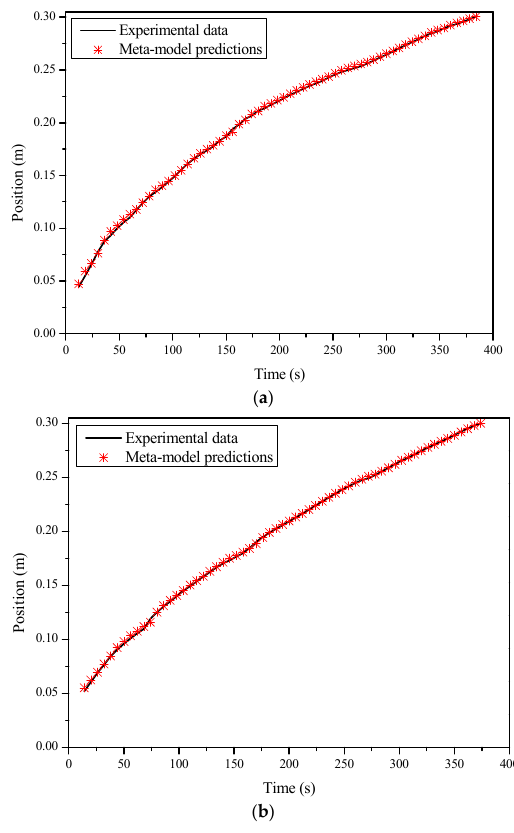
Figure 6. Comparison between the meta-model predictions and the results from ( a ) the first experiment; ( b ) the second experiment.